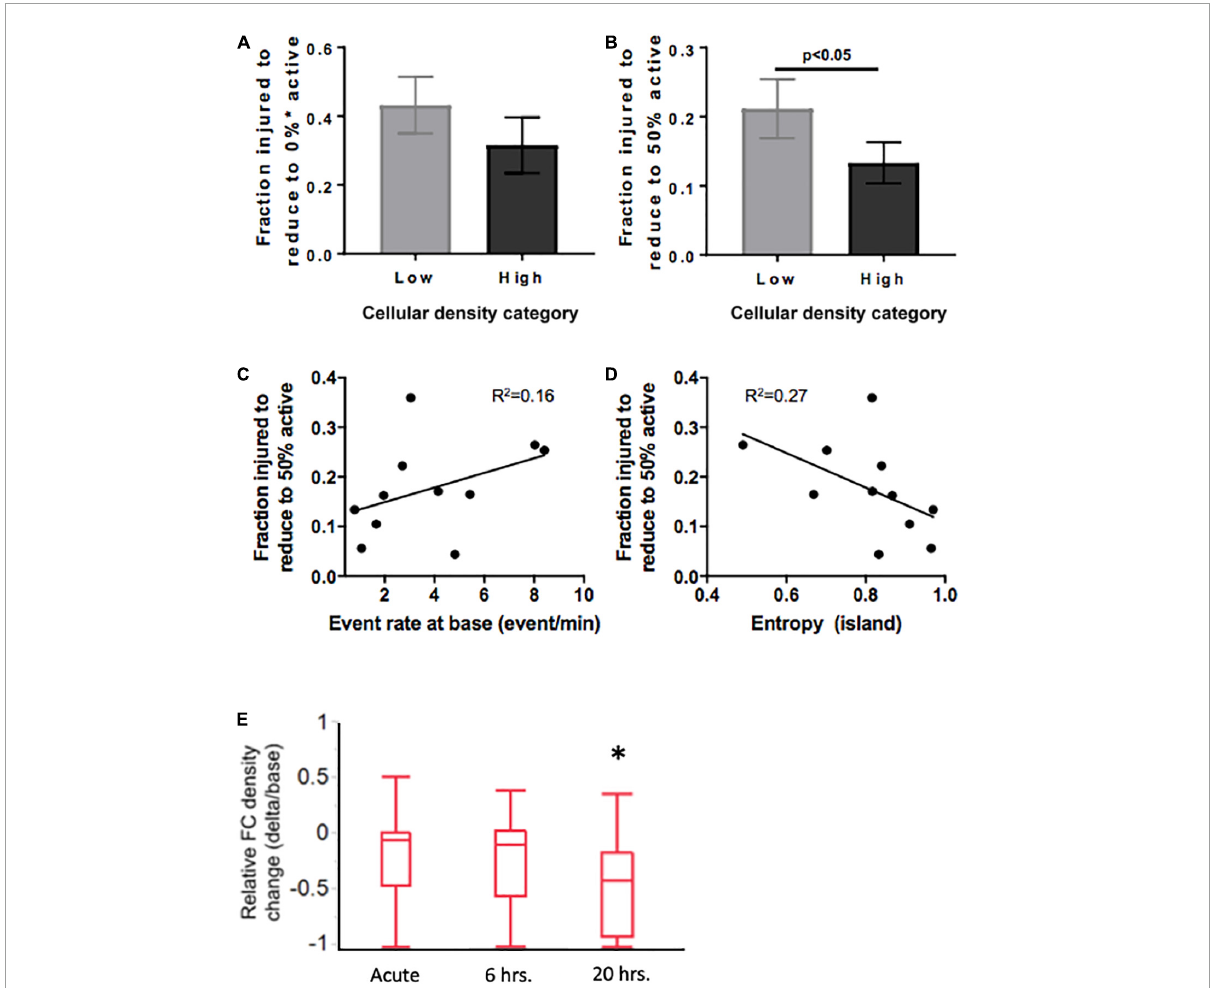
FIGURE9 Mediators of resilience in response to sequential microablation of neuronal islands’ population. (A) The total fraction of cells that need to be eliminated from an island to completely reduce their active population to 0 was not dependent on cellular density. (B) High density islands required significantly lower injury levels to reach the half-point of activity level (50% of population maintains activity). This response was only moderately dependent on the baseline activity of the island as described by baseline event rate (C) or entropy (D) . Inactivating 15–25% of neurons in high density islands led to no significant change in relative functional connectivity density either immediately or 6 h after injury, but did lead to a significant reduction in the relative functional connectivity density 20 h after microtrauma (E) . Significance level was set at * p <